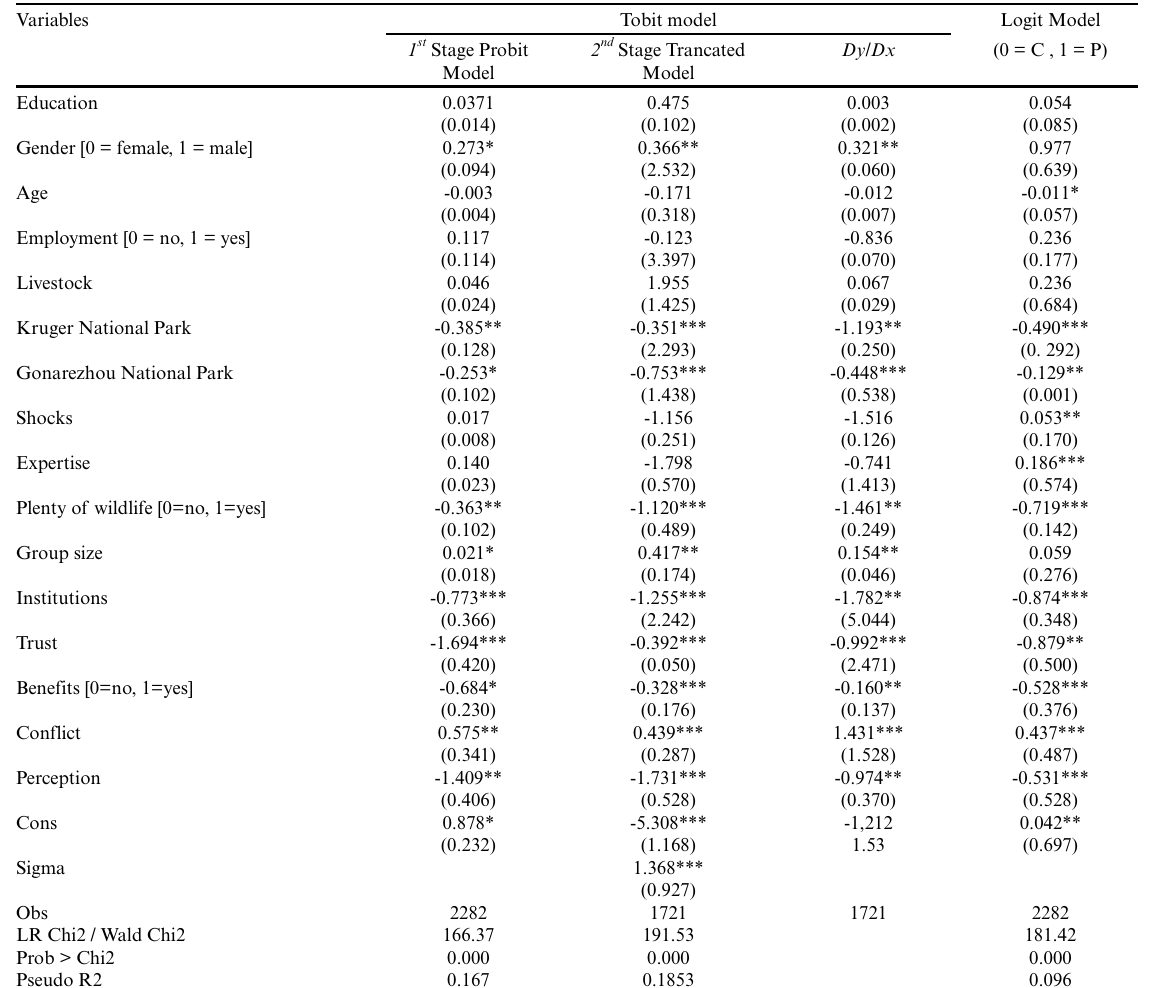
Table 6 . Regression